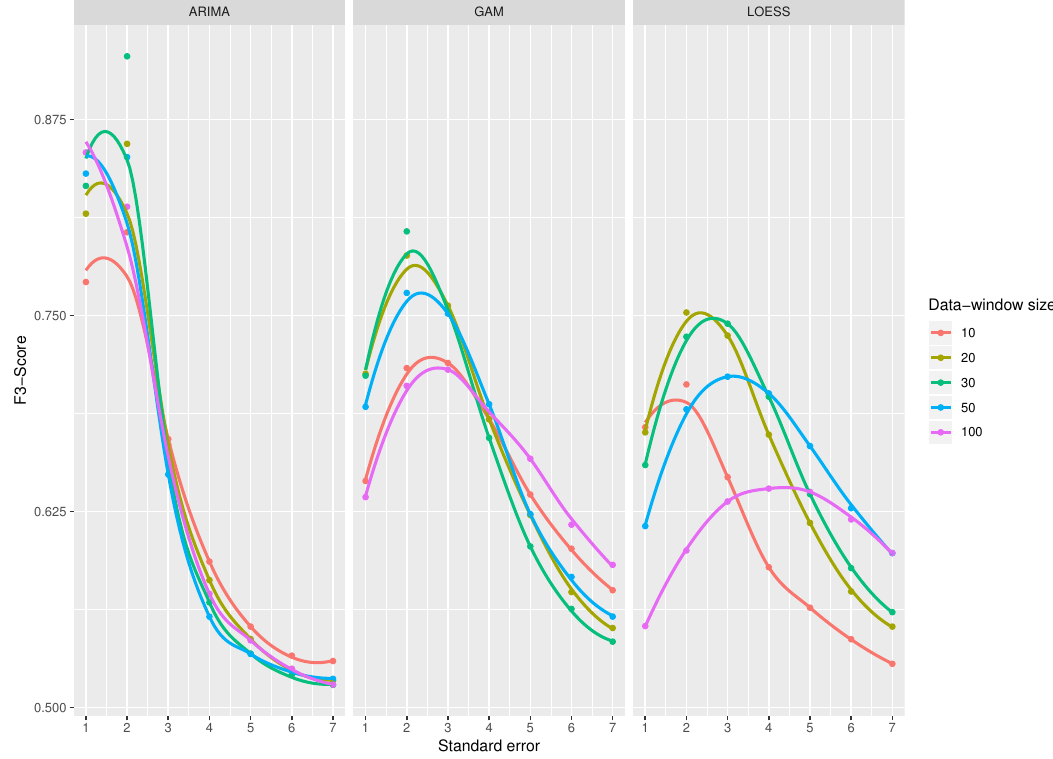
Figure 13. Comparison chart among functions, data-window sizes and standard errors.